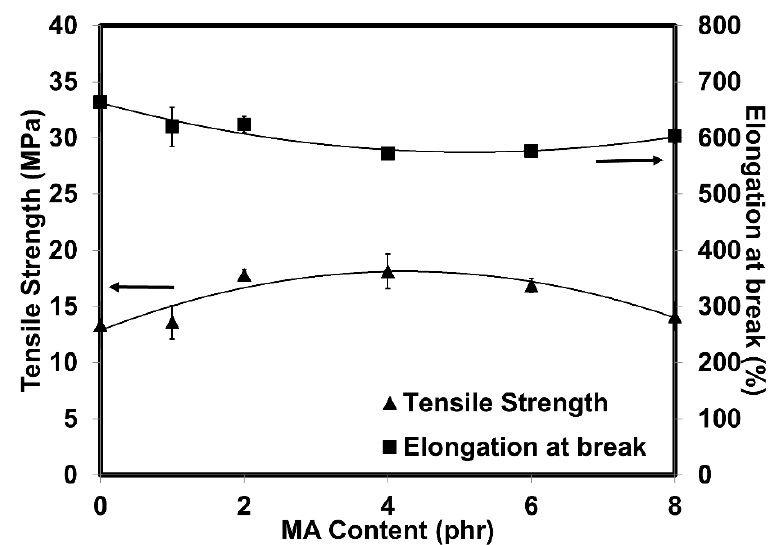
Figure 5. Tensile strength and elongation at break of NR/HNT and MNR/HNT composites. Processes 2020 , 8 , x FOR PEER REVIEW